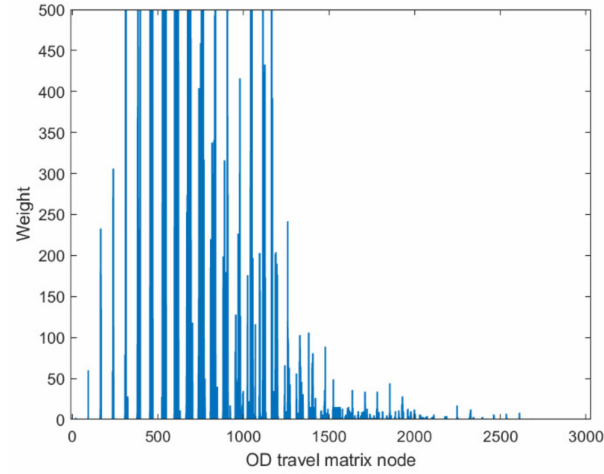
Figure 15. In-degree of each node in the OD travel matrix.